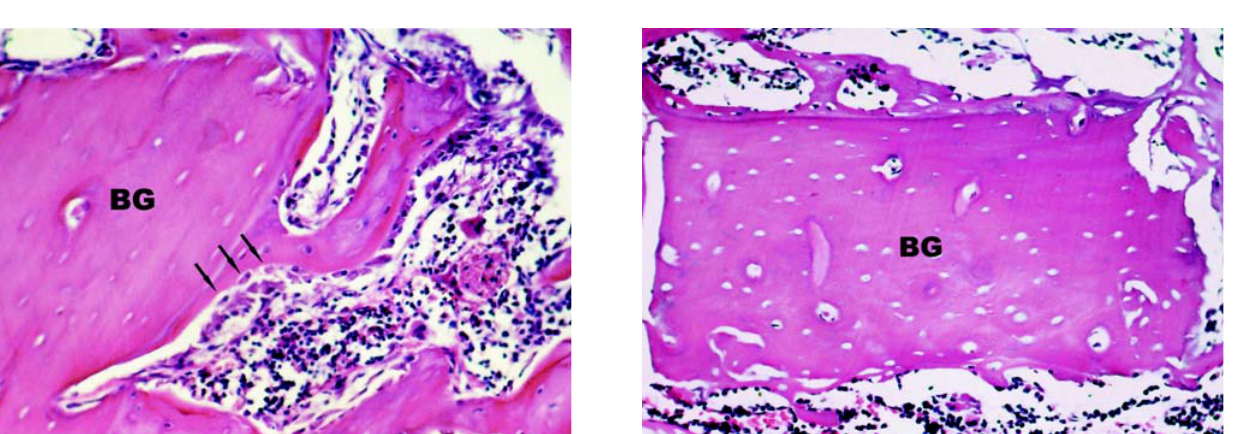
FIGURE 2- Group DG10: Devitalized bone graft (GB) characterized by the absence of osteocytes inside the mineralized material. Osteoblasts around the newly formed bone and the graft, showing new bone formation activity.